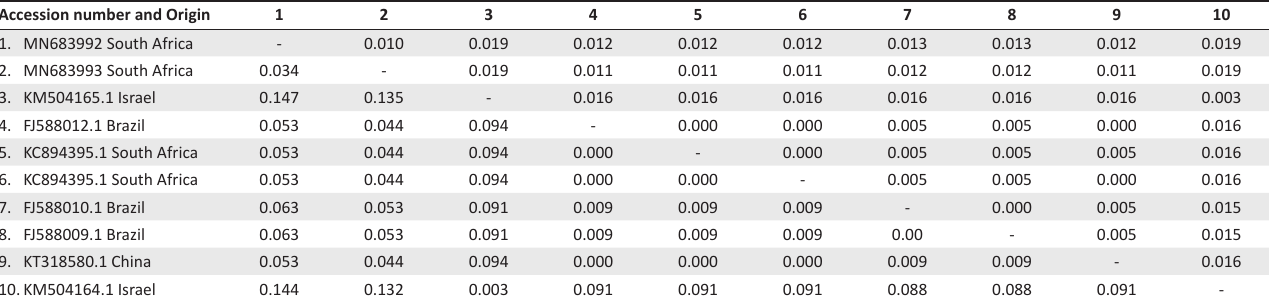
FIGURE 2: In phylogenetic tree analysis of Babesia bovis based on RAP-1 gene, the tree was constructed with maximum likelihood method based on the Tamura-3-parameter model, with bootstrap values (expressed as percentages of 1000 replications) superimposed at branching points. The sequences produced in this study are shown with bullet points. The evolutionary distances were computed using the p -distance method. Babesia orientalis was used as an out- TABLE 4: Evolutionary divergence of Babesia bovis representing 320 base pair region and expressed as pairwise distance ( p -distance) (bottom left) and standard error (top right). Accession number and Origin